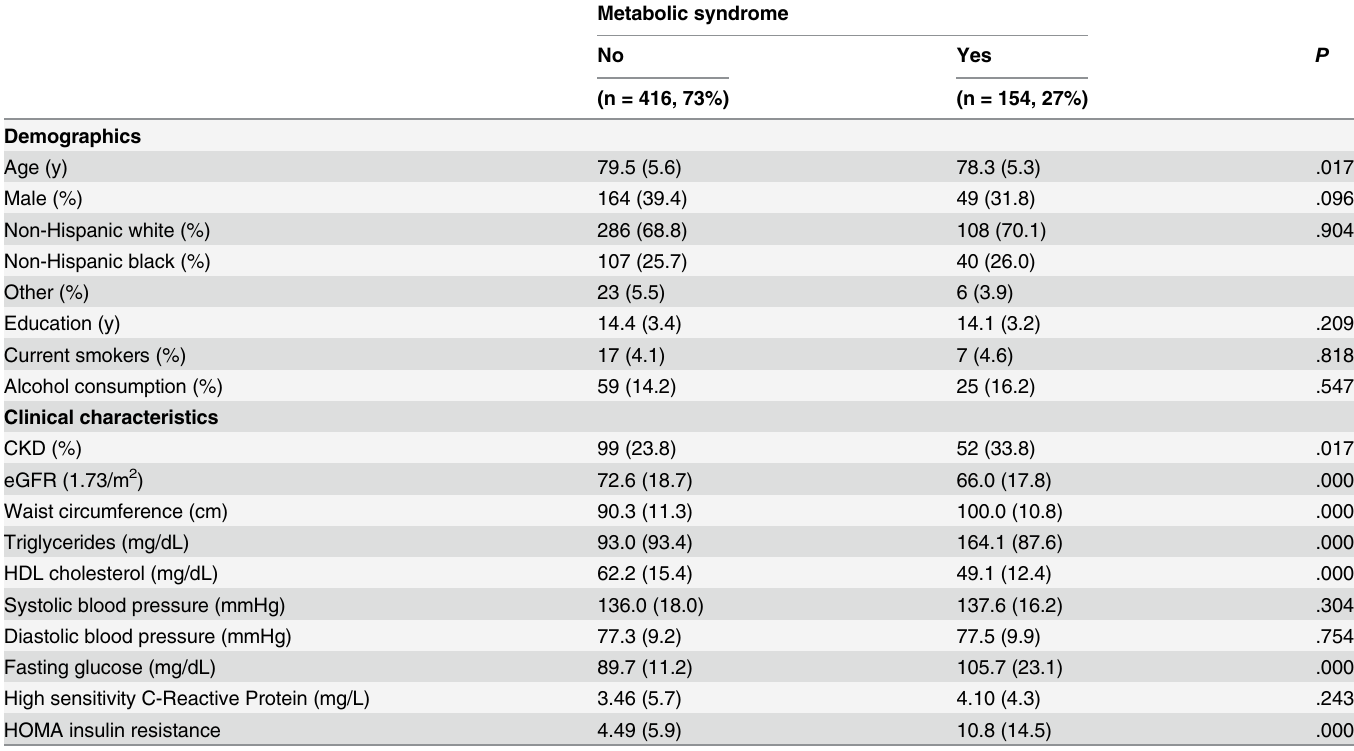
Table 1. Demographic and clinical characteristics of the study participants with and without the metabolic syndrome.